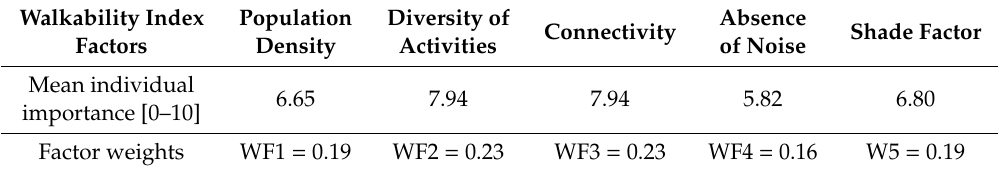
Table 3. Factor weights of WI and their individual importance.